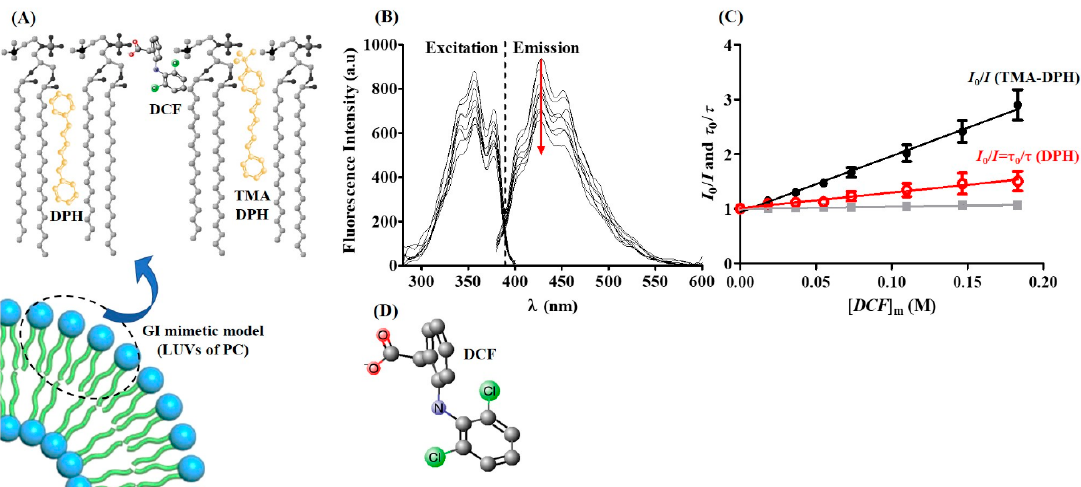
Figure 3. ( A ) Schematic representation of the possible location/orientation of the fluorescent probes TMA-DPH and DPH (yellow structures) and the drug DCF within PC molecules of the lipid bilayer. ( B ) Excitation and emission spectra of the fluorescence probe TMA-DPH incorporated in LUVs of DMPC. Red arrow shows the fluorescence quenching effect of increasing concentrations of DCF added to the labeled system at a temperature of 37 °C and pH 5.0. ( C ) Stern-Volmer plots of the probes TMA-DPH and DPH incorporated in LUVs of DMPC at a temperature of 37 °C and pH 5.0 as a function of DCF membrane concentrations. Grey symbols ( ) were obtained from fluorescence lifetime measurements of TMA-DPH; black closed symbols ( ) were obtained from fluorescence steady-state measurements of TMA-DPH; and red open symbols ( ) were obtained from fluorescence steady-state/lifetime measurements of DPH. All are average values ± standard deviation of at least three independent measurements. Lines are the best fit according to Equation (2). ( D ) DCF molecule with the quenching moieties (O, N, and Cl) highlighted.